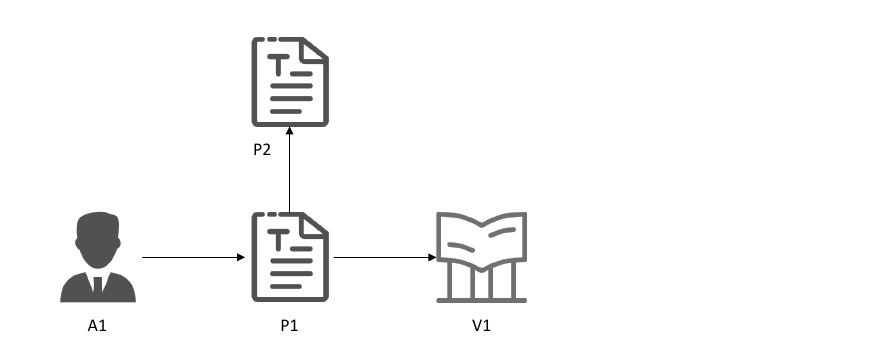
Figure 1. The toy example of the academic network. Here the three links represent three edge types. Problem 1. Representation learning on heterogeneous graph: Given a heterogeneous network G = ( V , E , A , R ) , the goal of heterogeneous graph representation learning is to learn a mapping function f : V → R d , which maps each node v ∈ V to a vector in the d-dimensional space R d , and d (cid:28) | V |